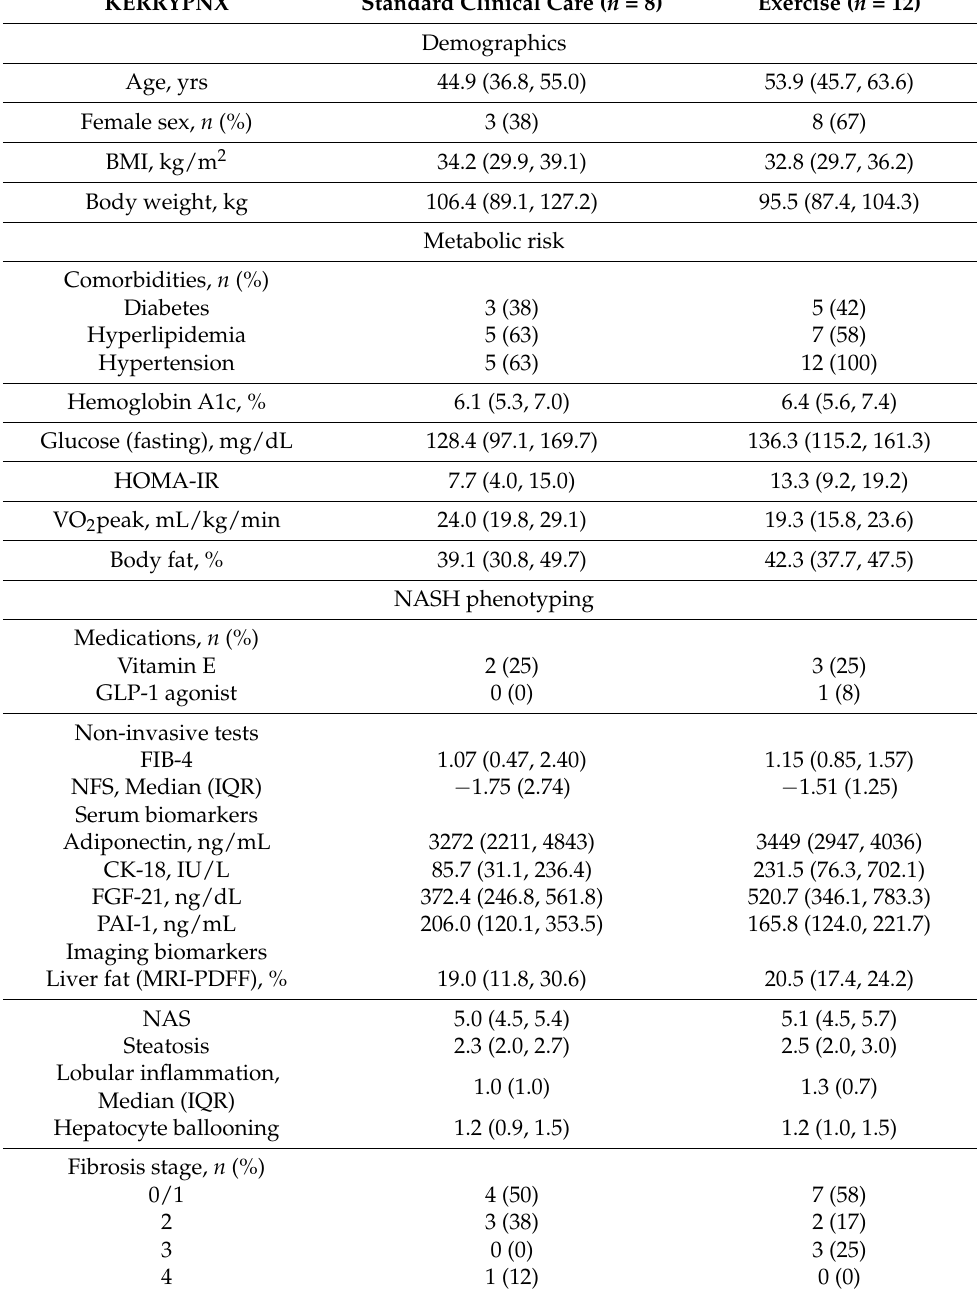
Table 1. Baseline comparisons between Exercise and Standard Clinical Care